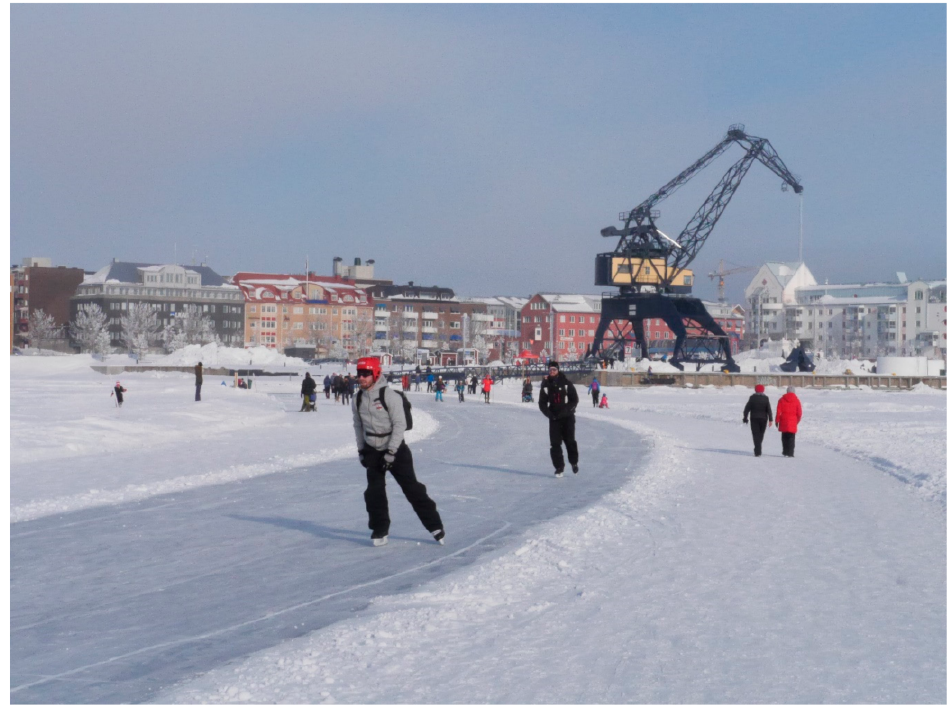
Figure 6. Photograph of Luleå’s ice road looking back toward the City’s southern